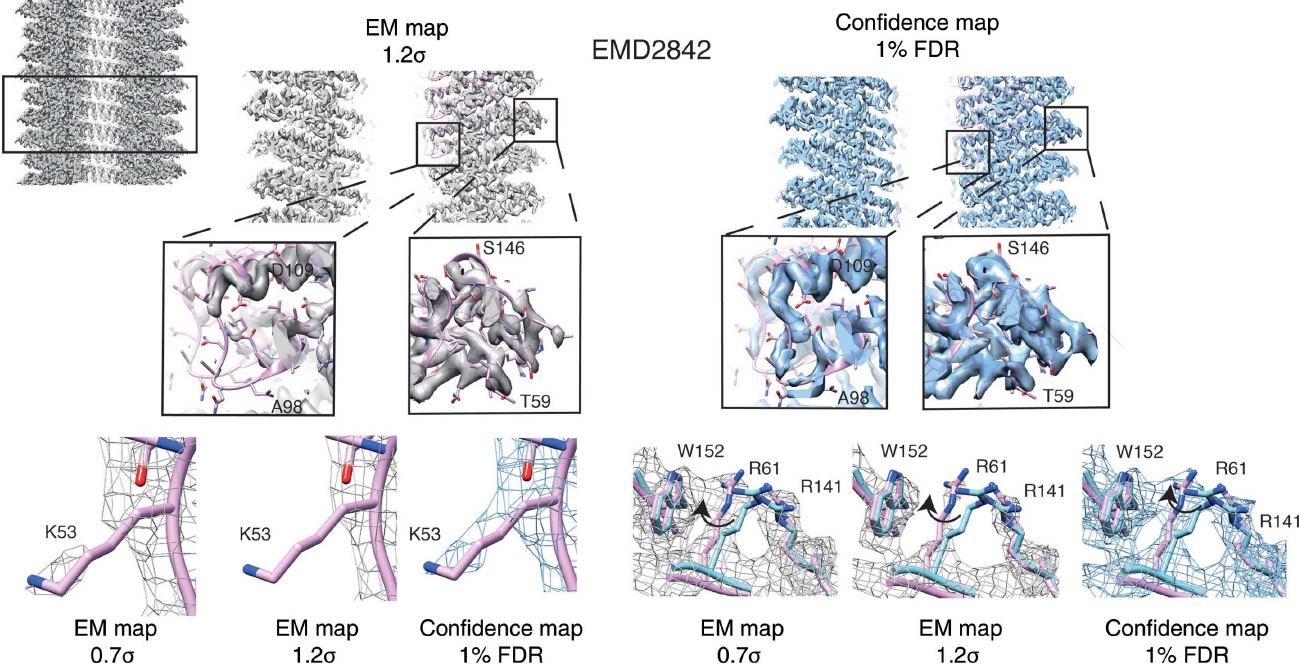
Figure 3 Confidence maps facilitate the detection of weak density features. Detailed comparison of TMV density and the corresponding confidence map. A slice view through the TMV rod with enlarged insets for inner and outer radii density (top). Lys53 side-chain density (left) and the molecular environment of Arg61 side chains (right) are shown at 0.7 (cid:2) and 1.2 (cid:2) thresholds and in a 1% FDR confidence